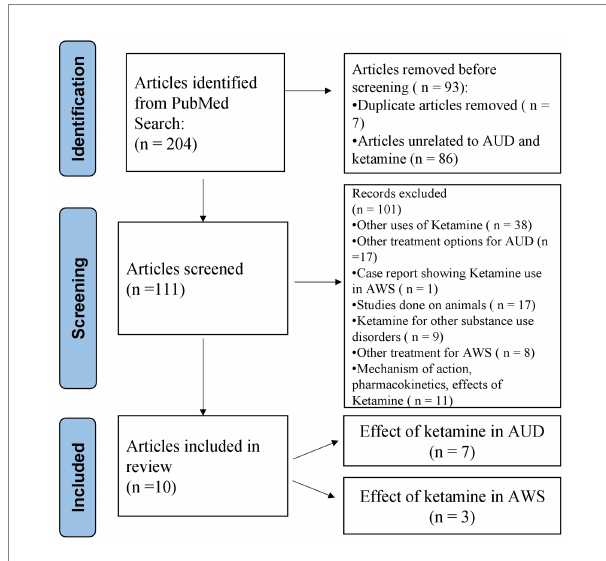
FIGURE 1 Identification of studies via databases using the PRISMA (Preferred Reporting Items for Systematic Reviews) flow